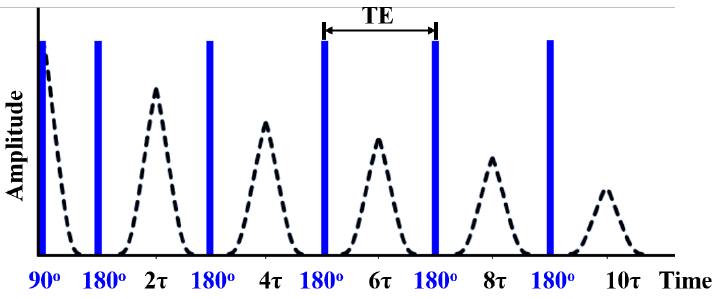
Figure 1. Schematic representation of the Carl-Purcell-Meiboom-Gill (CPMG) pulse sequence.